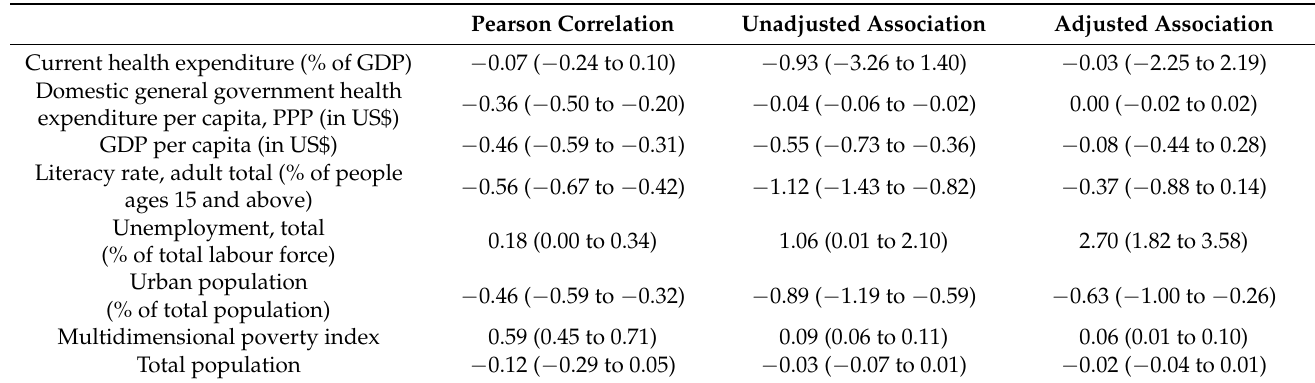
Table 2. Country-level factors associated with prevalence estimates across countries in LMICs. Pearson